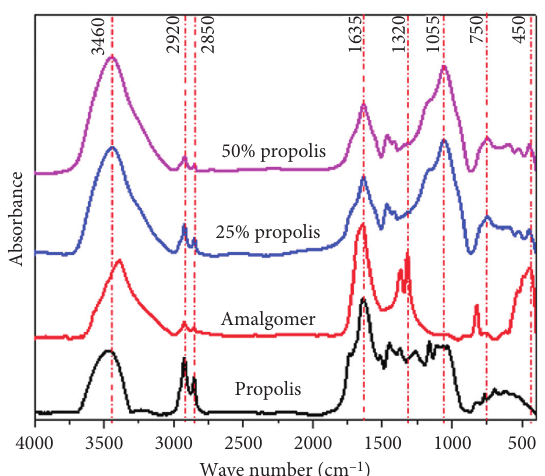
Figure 1: FTIR Absorption spectra of the studied